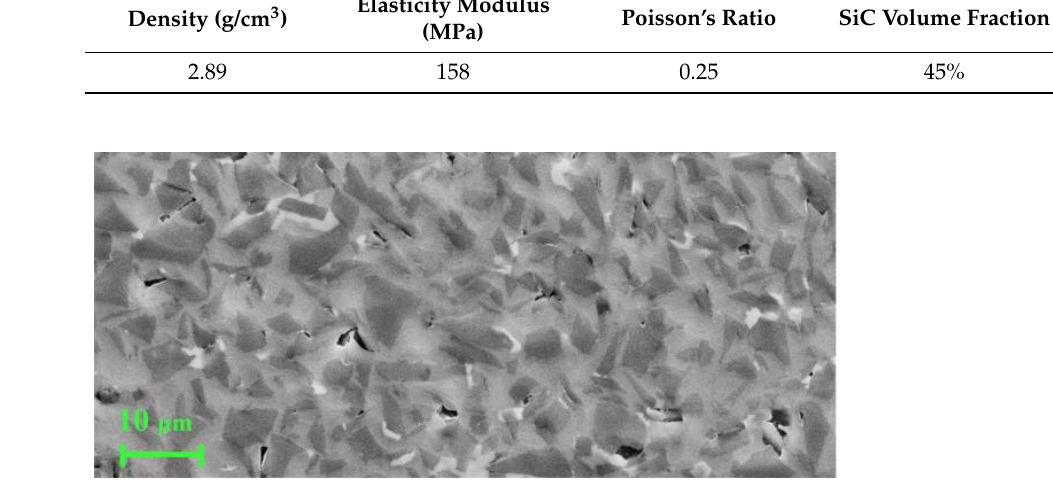
Figure 6. The SEM image of ( a ) non-textured tool surface after orthogonal cutting; ( b )micro-tip- ping; ( c ) micro-crack; ( d ) adhesion; ( e ) micro-crack. Figure 7 shows the energy-spectrum image of the non-textured tool surface in the area near the crack (black spot). Carbon was mainly found to be distributed in this region, with only a small amount of aluminum and silicon. This was caused by the adhesive SiC